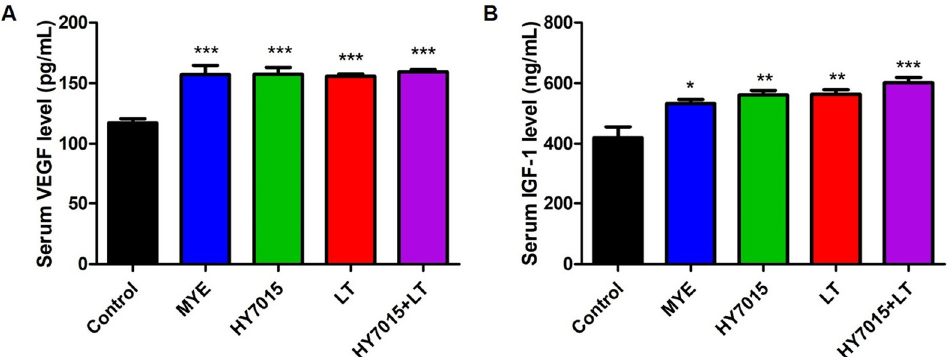
Figure 6. Effect of Lactobacillus paracasei HY7015 (HY7015) and/or Lycopus lucidus Turcz. (LT) extract on growth factor secretion in mouse serum. ( A ) VEGF levels in mouse serum. ( B ) IGF-1 levels in mouse serum. VEGF and IGF-1 secretions were measured by ELISA. Data are presented as mean ± SE. Significant differences are indicated by * p < 0.05, ** p < 0.01, and *** p < 0.001, relative to the control group. SE, standard error; MYE, medicinal yeast extract; HY7015, Lactobacillus paracasei HY7015; LT, Lycopus lucidus Turcz.; HY7015+LT, Lactobacillus paracasei HY7015 with Lycopus lucidus Turcz.; ELISA, enzyme-linked immunosorbent assay.